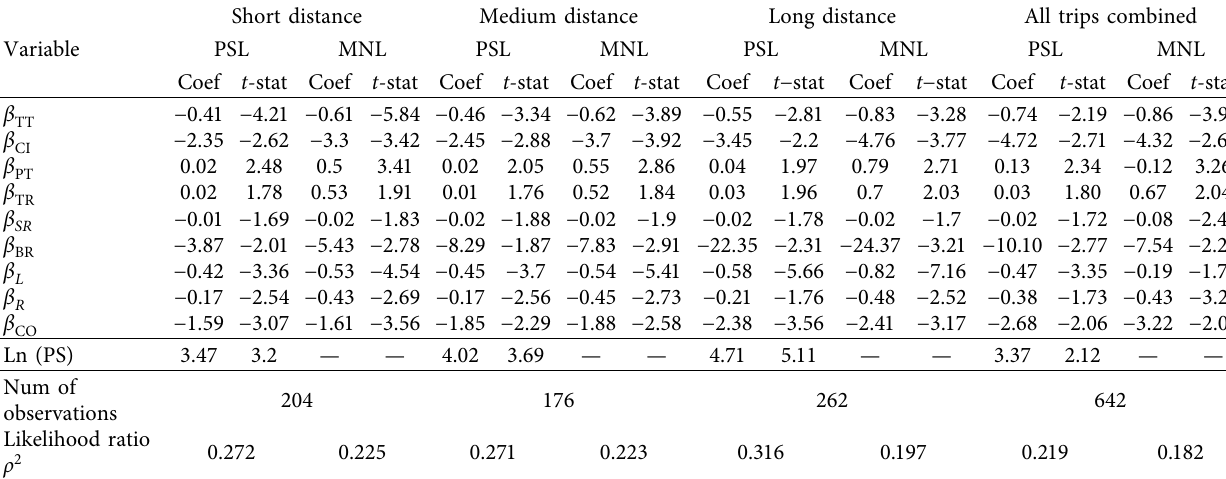
Table 5: Calibration results of taxi passenger-carrying route choice model.